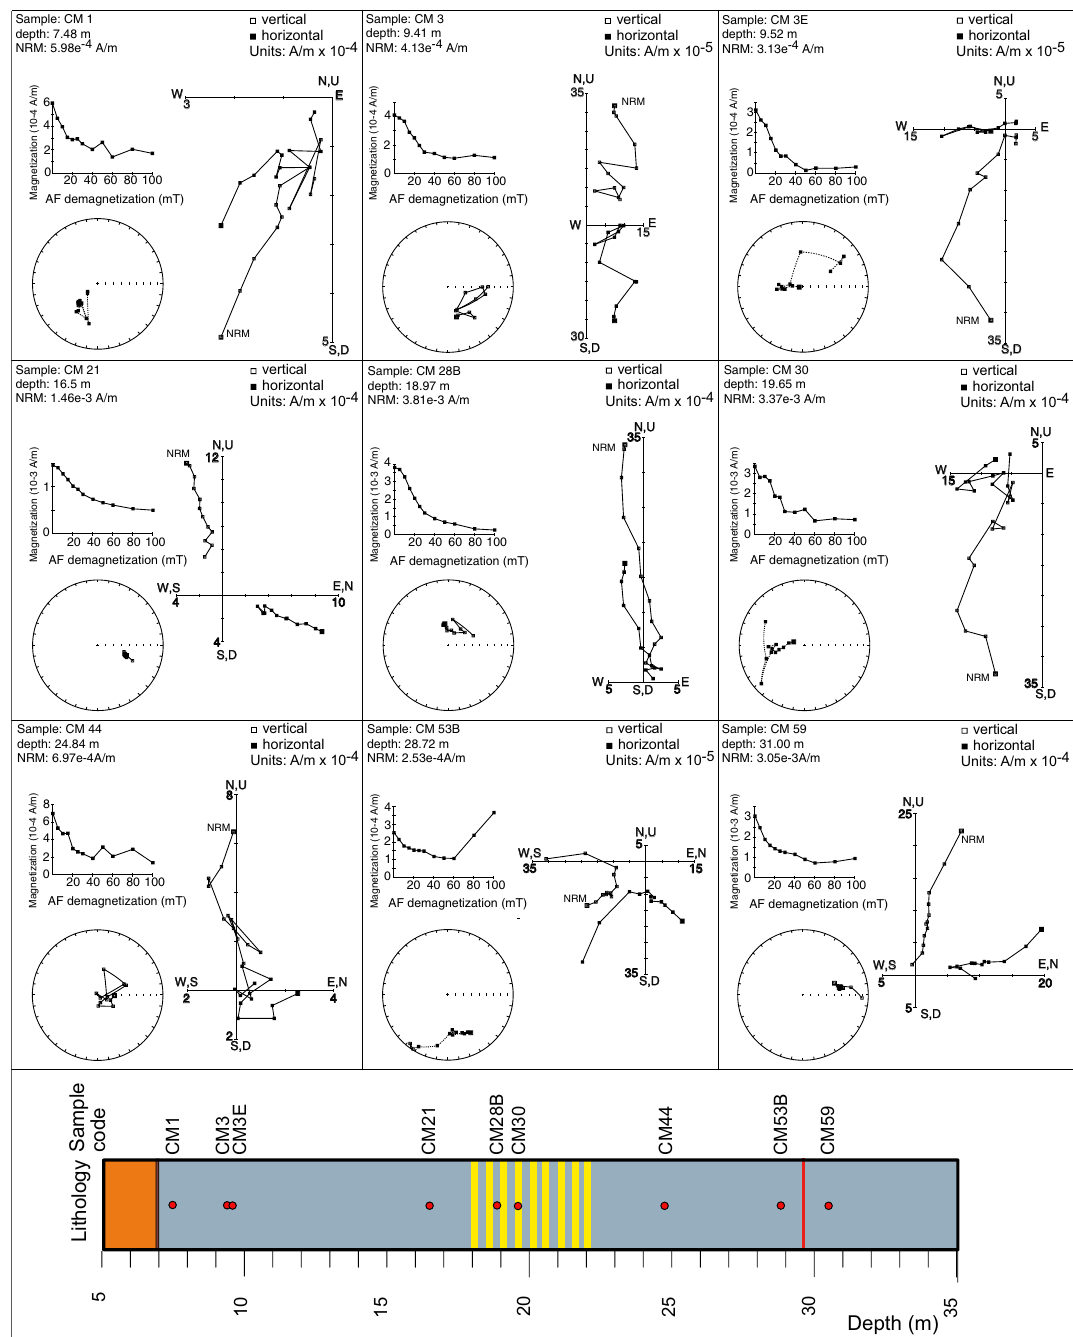
Figure 5. AF (alternating field) demagnetization behavior for 9 representative samples from CM1. For the vector component diagrams, open (closed) symbols represent projections onto the vertical (horizontal) plane. The stereoplots are equal-area projections, with solid (open) symbols representing points projected onto the lower (upper) hemisphere. The cores were not azimuthally oriented; declinations are reported in the laboratory coordinate system with respect to the split face of the core. Plots were produced using PuffinPlot 35